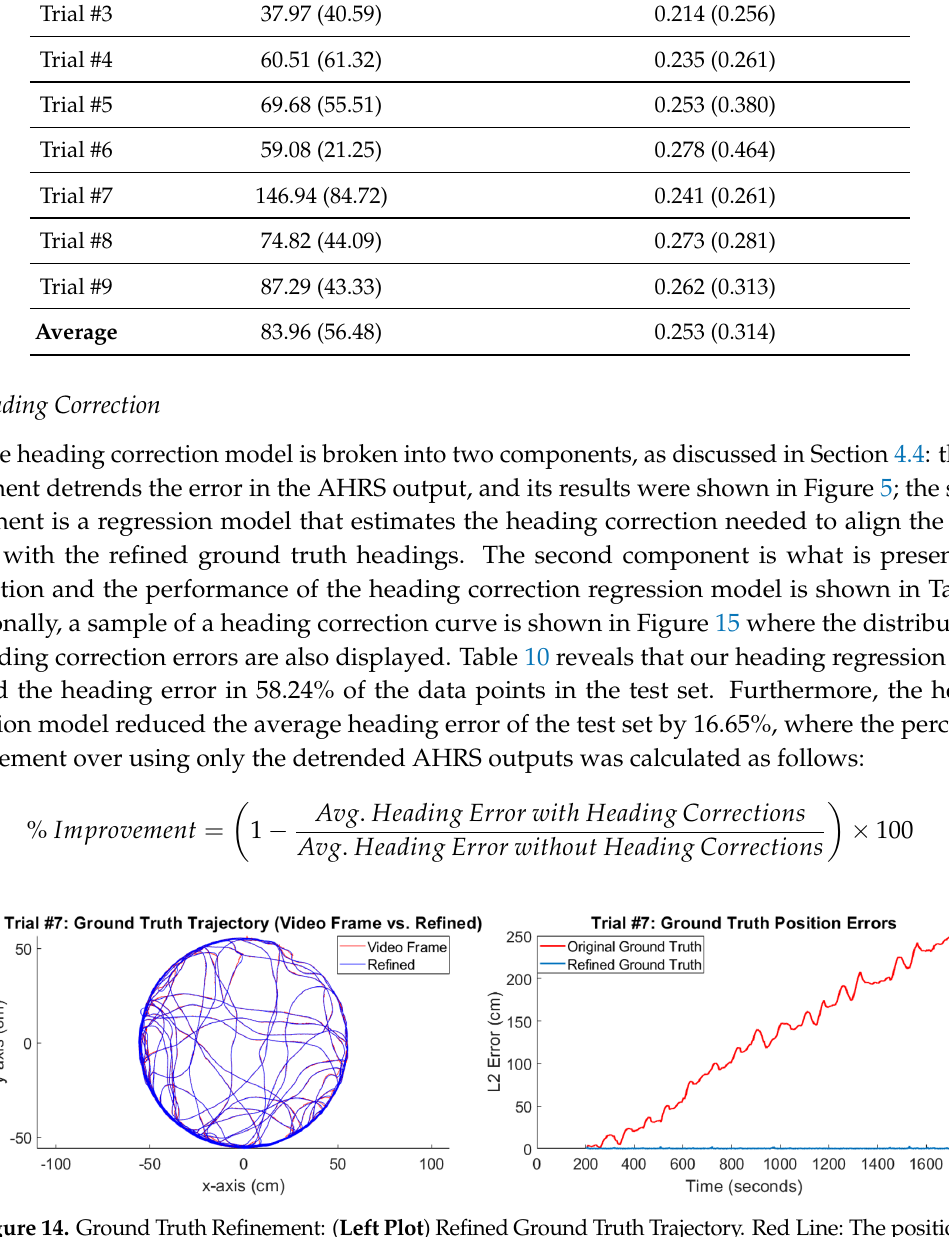
Figure 14. Ground Truth Refinement: ( Left Plot ) Refined Ground Truth Trajectory. Red Line: The position trajectory obtained from the video frames themselves. Blue Line: The position trajectory obtained by integrating the speeds and headings that have been refined via the ground truth refinement algorithm (Section 4.6). ( Right Plot ) Ground Truth Position Errors. The figure shows the distance between the position trajectory obtained from the video frames and the position trajectory that is integrated from the speeds and headings. Red Line: The original speeds and headings that are obtained from the video frames themselves. Blue Line: The refined speeds and headings that are obtained from the ground truth refinement algorithm. The ground truth refinement algorithm corrects the speeds and headings obtained from the video frames so that the position error does not grow over